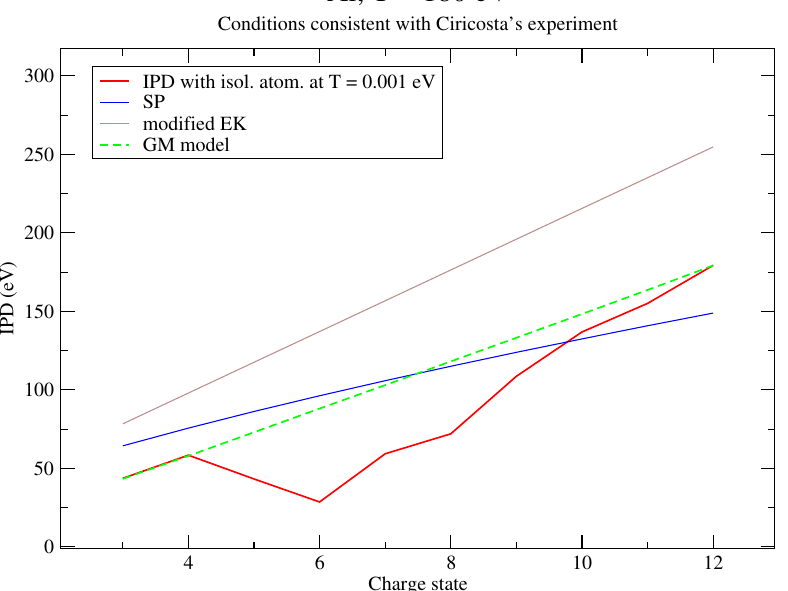
Figure 11. IPD of the different charge states for an aluminum plasma at T = 180 eV: our calculation (red curve), Stewart-Pyatt model (blue curve), modified Ecker-Kröll model (brown curve) and GM model (green dashed